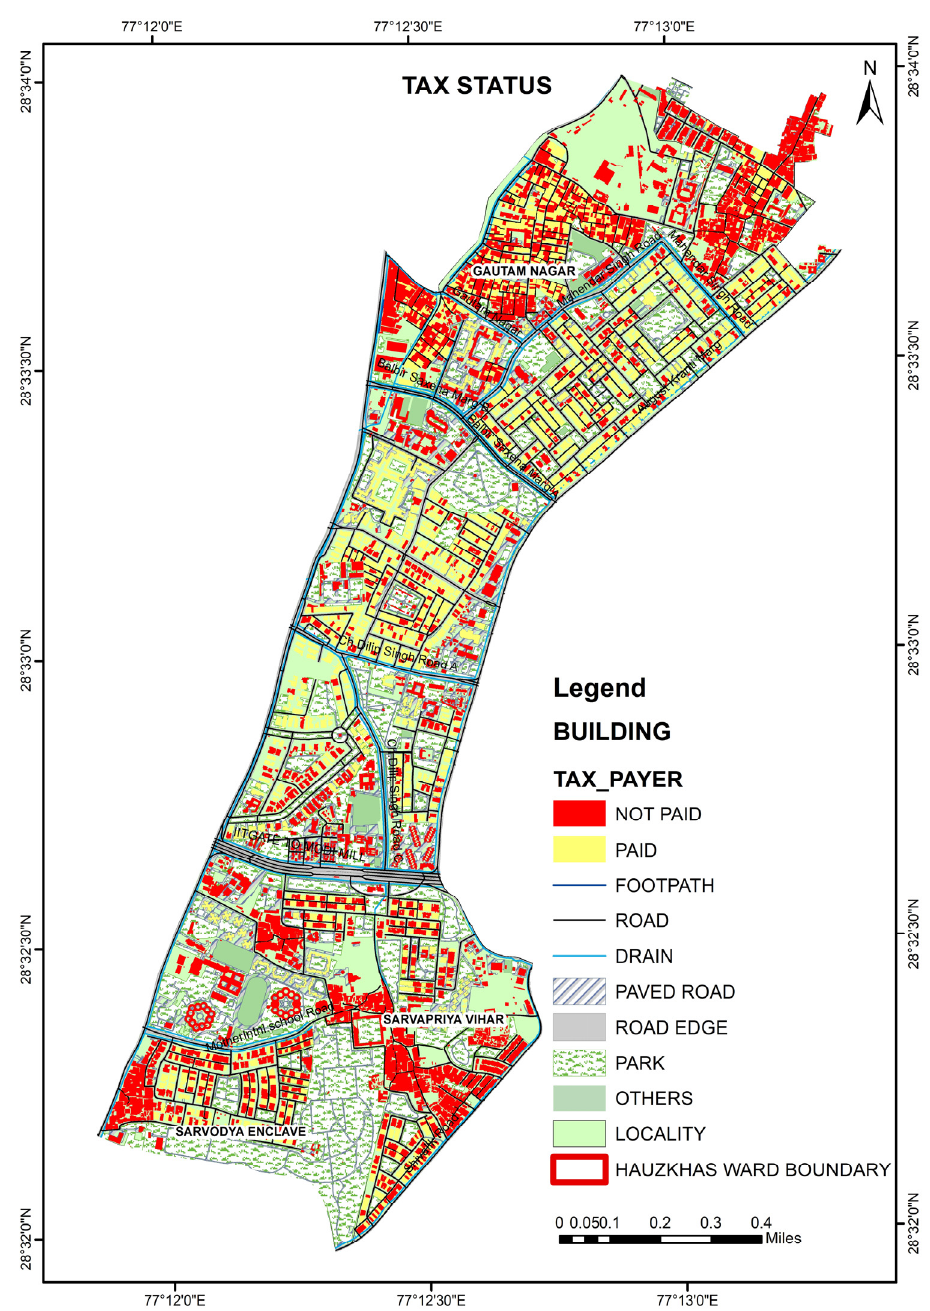
Figure 8. Annual tax payers status in the geodatabase.